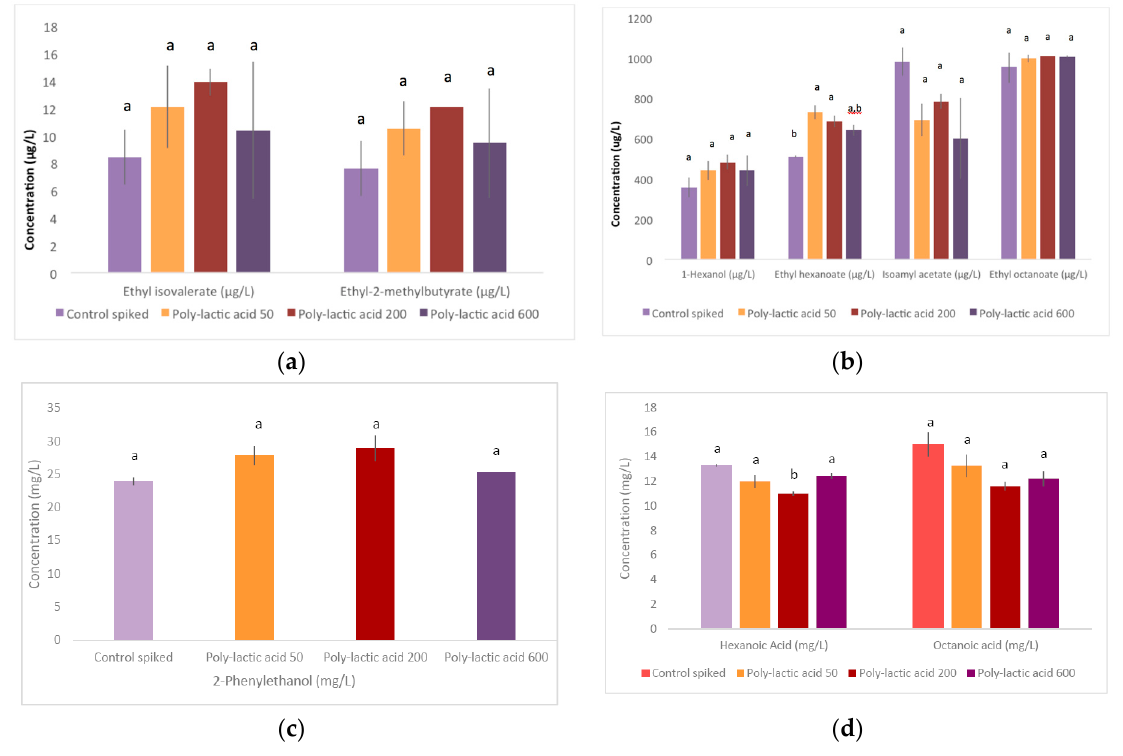
Figure 3. Concentrations of ( a ) ethyl isovalerate, ethyl 2-methylbutyrate; ( b ) ethyl butyrate, hexanol, ethyl hexanoate, isoamyl acetate, ethyl octanoate; ( c ) phenylethanol and ( d ) hexanoic acid and octanoic acid in untreated (‘control spiked’) wine and wine treated with polylactic acid of varying surface areas (50 cm 2 /L, 200 cm 2 /L and 600 cm 2 /L). Data represent mean values ± standard deviations. Wines with different letters have significantly different concentrations for each compound (Tukey’s HSD 0.05 ).